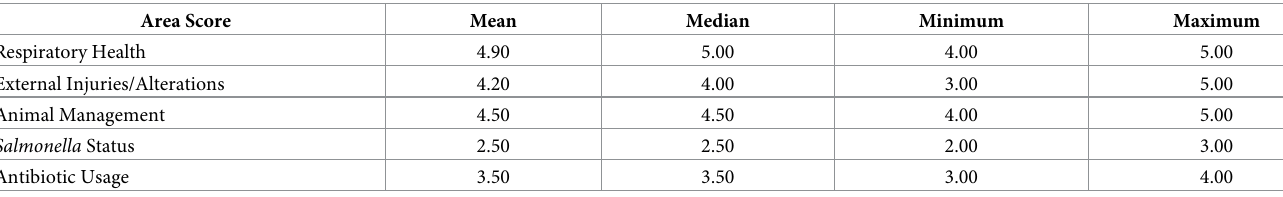
Table 3. Expert opinion ranking of area scores for the final overall